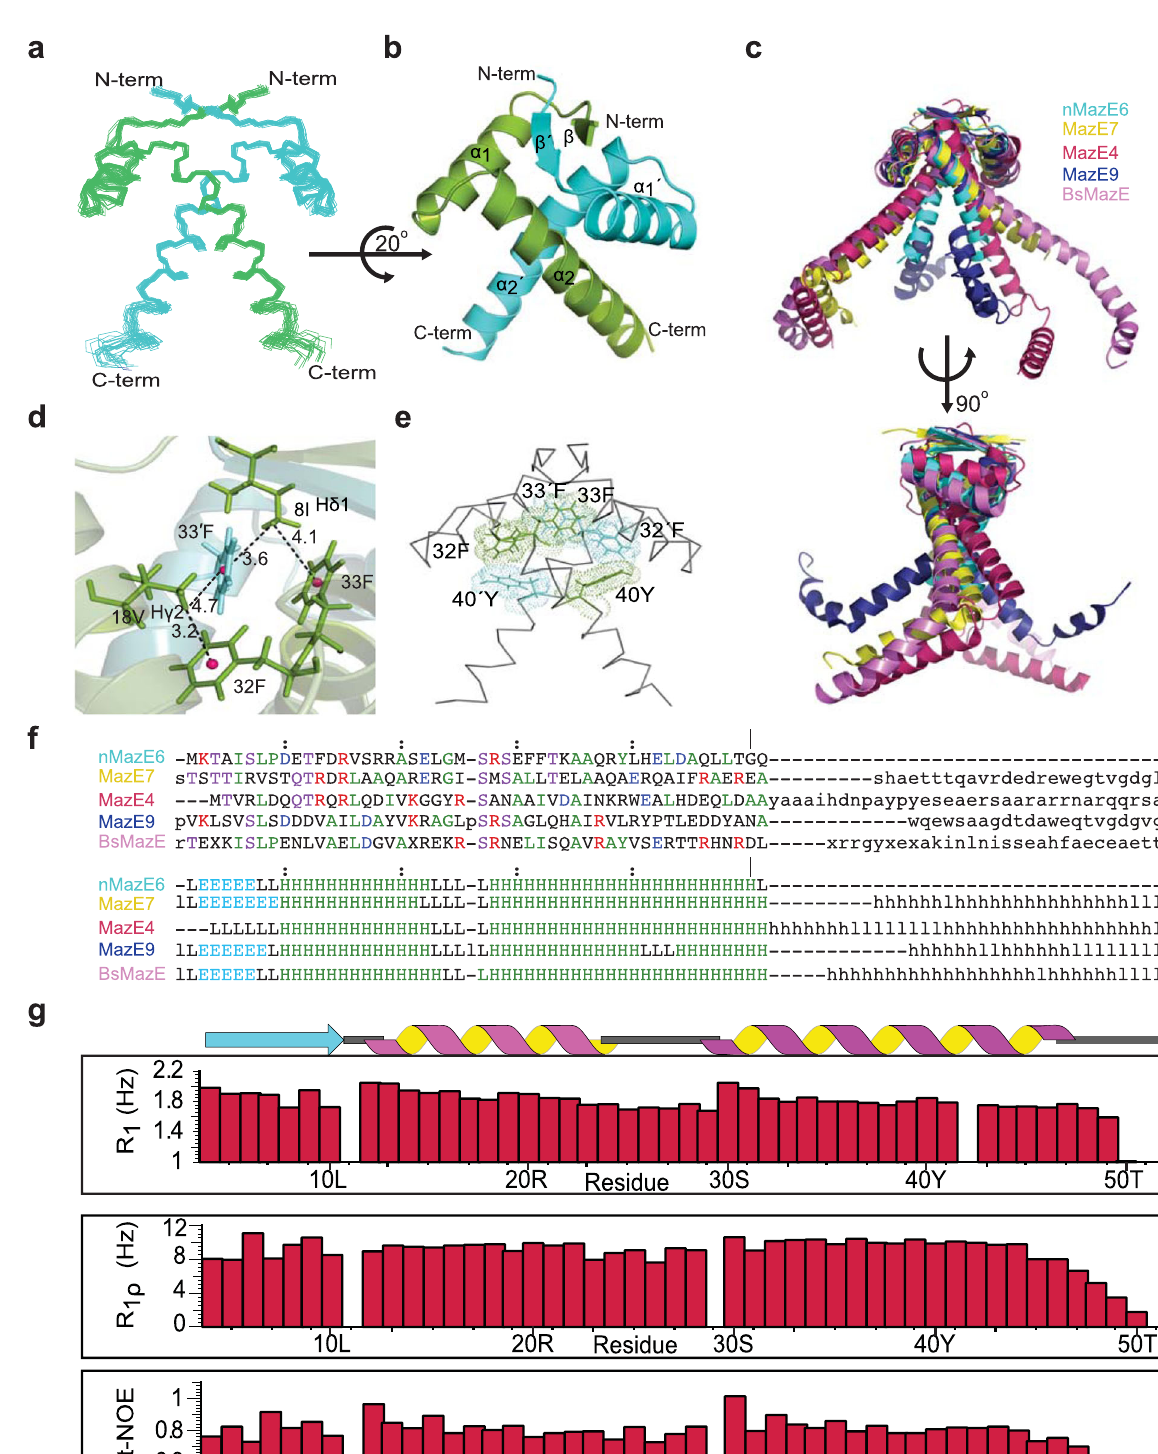
Calorimetry (ITC) data. The interaction of nMazE6 with its cognate DNA is exothermic in nature with a dissociation constant of 0.22 μ M and stoichiometric value(n) of 0.93 indicating an 1:1 interaction (Fig. 6a). Table 2 shows the results obtained from ITC experiments. No heat change was observed for the interaction of nMazE6 with scrambled DNA and a very small heat change